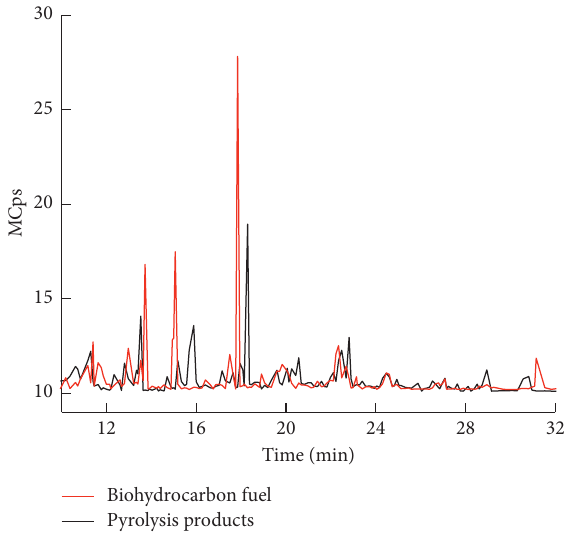
Figure 16: GC-MS spectra of pyrolysis products and biohydrocarbon